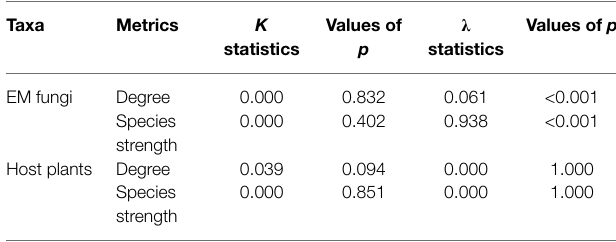
TABLE 2 | Phylogenetic signal of plant-ectomycorrhizal fungal (EM)